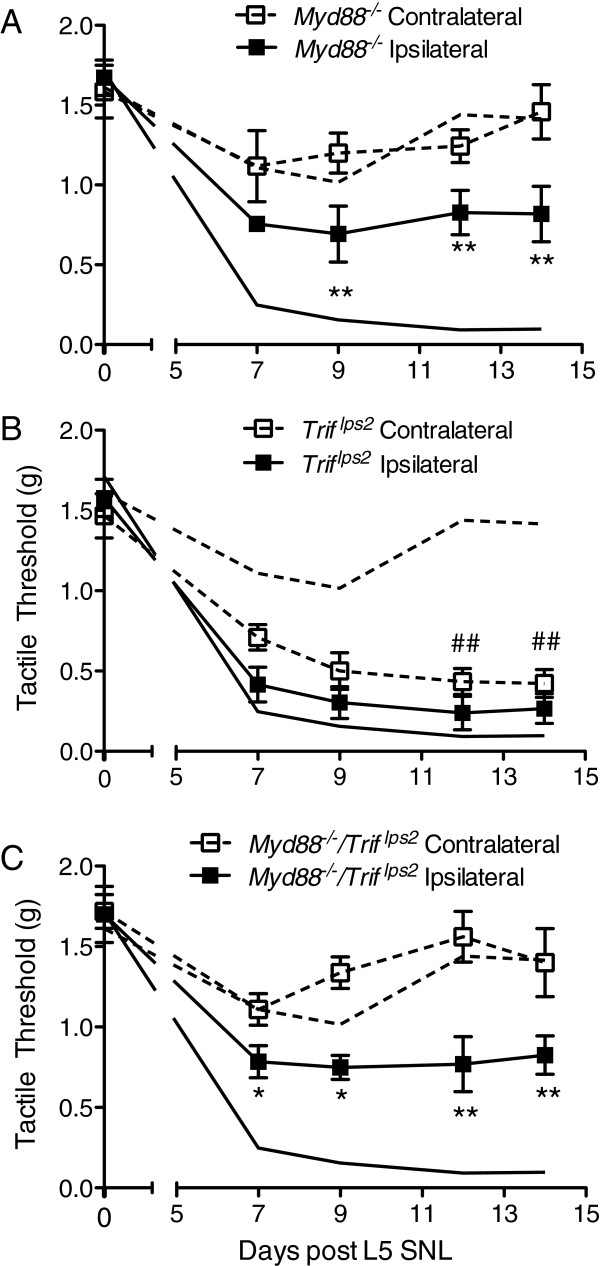
TRIF is important for unilateral tactile allodynia phenotype following L5 SNL. L5 SNL was performed on (A)Myd88-/-, (B)Triflps2, and (C)Myd88-/-/Triflps2 mice. Mice were allowed to recover and were tested at days 7, 9, 12, and 14 post-SNL. The solid black line and dashed line represents the C57BL/6 ipsilateral and contralateral thresholds, respectively. Both (A)Myd88-/- and (C)Myd88-/-/Triflps2 ipsilateral tactile thresholds were significantly different from the C57BL/6 thresholds beginning 7 days post-L5 SNL. Surprisingly, the (B)Triflps2 mice displayed a tactile allodynia in both ipsilateral and contralateral paws. The Triflps2 ipsilateral paw thresholds were not significantly different from the C57BL/6 mice, but the contralateral paws were significantly different beginning at day 12 post-L5 SNL. Data are expressed as mean ± SEM (n = 5–8 mice/group) and analyzed via 2-way ANOVA, followed by Bonferroni post hoc test to compare each time point to the respective C57BL/6 group, ipsilateral or contralateral (*P <0.05 or **P <0.01 for ipsilateral group; ##P <0.01 for contralateral group).